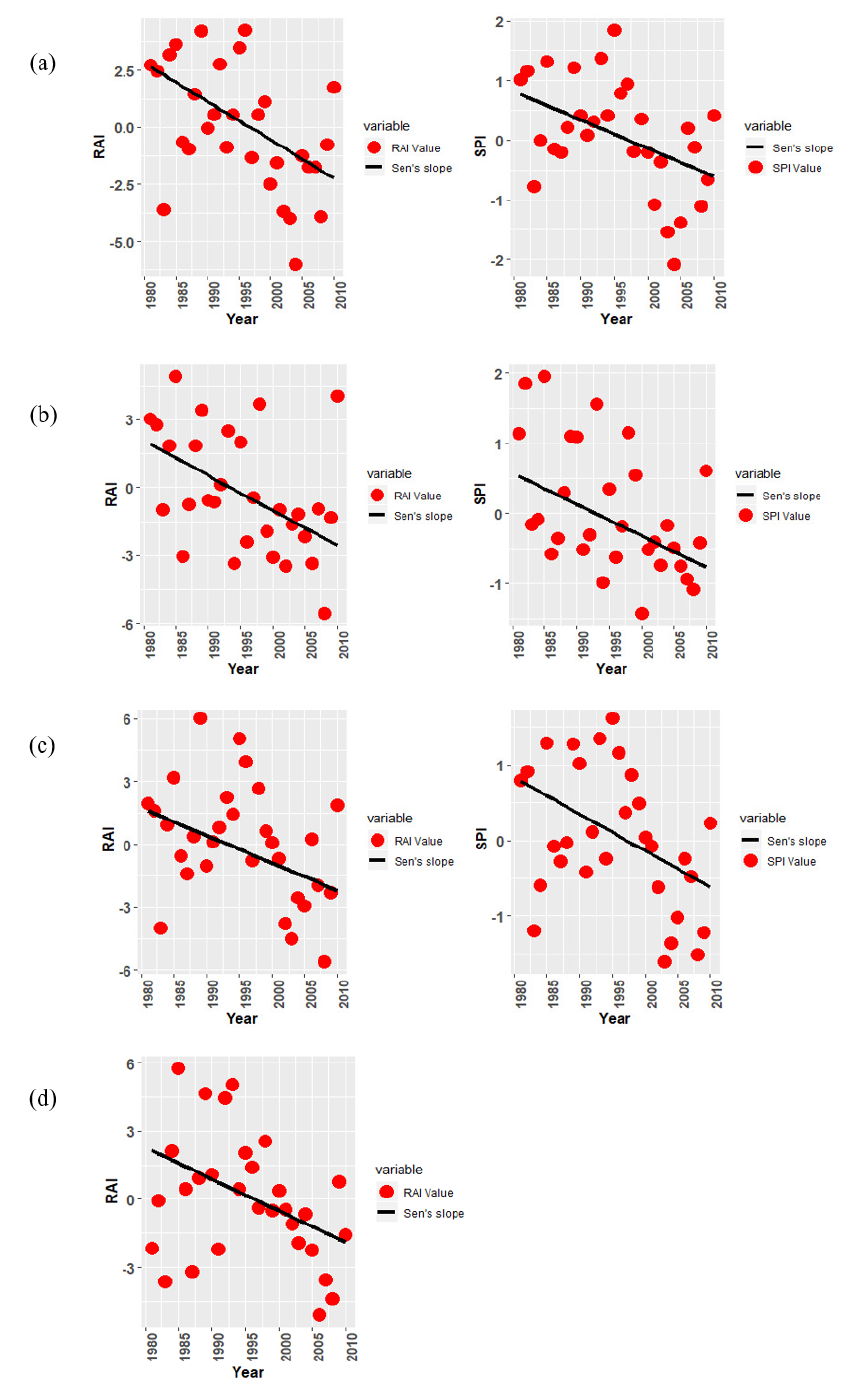
Figure 4: RAI and SPI trend plots for (a) Ambewela (b) Katugastota (c) Nuwara Eliya (d) Hatton rain gauge stations during the period of 1981 -